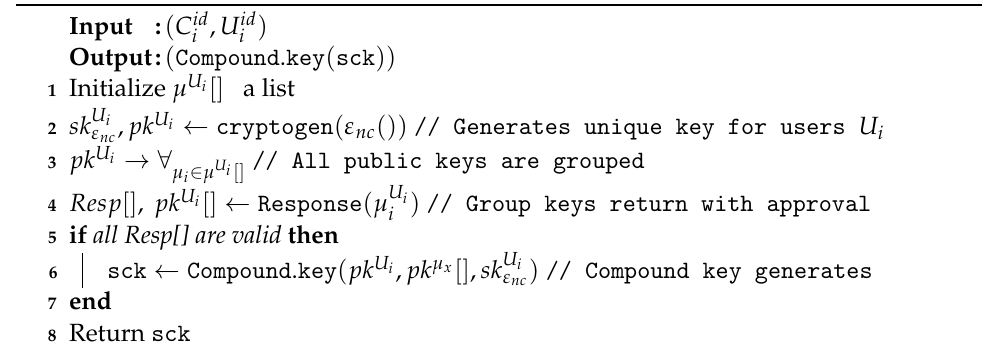
Algorithm 1: Compound Key Generation